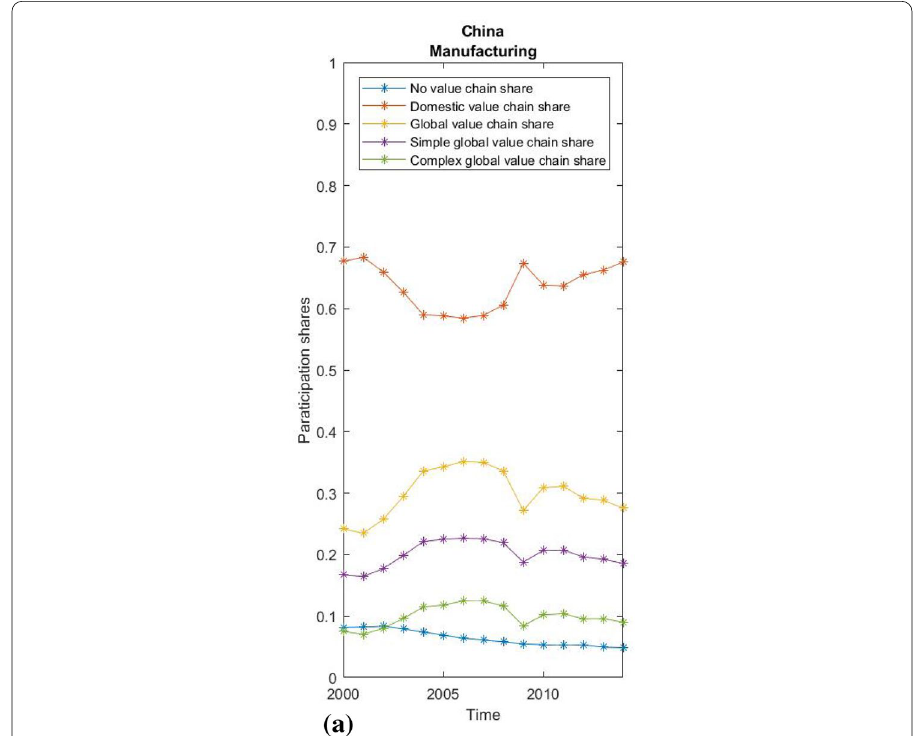
Fig. 5 China manufacturing participation rates. Source: WIOD, 2016; own